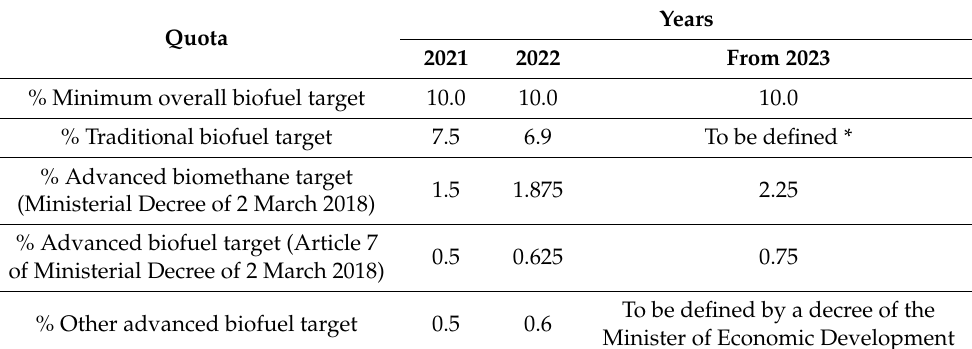
Table 1. Mandatory quota for biofuels and advanced biofuels in Italy (Ministerial Decree of